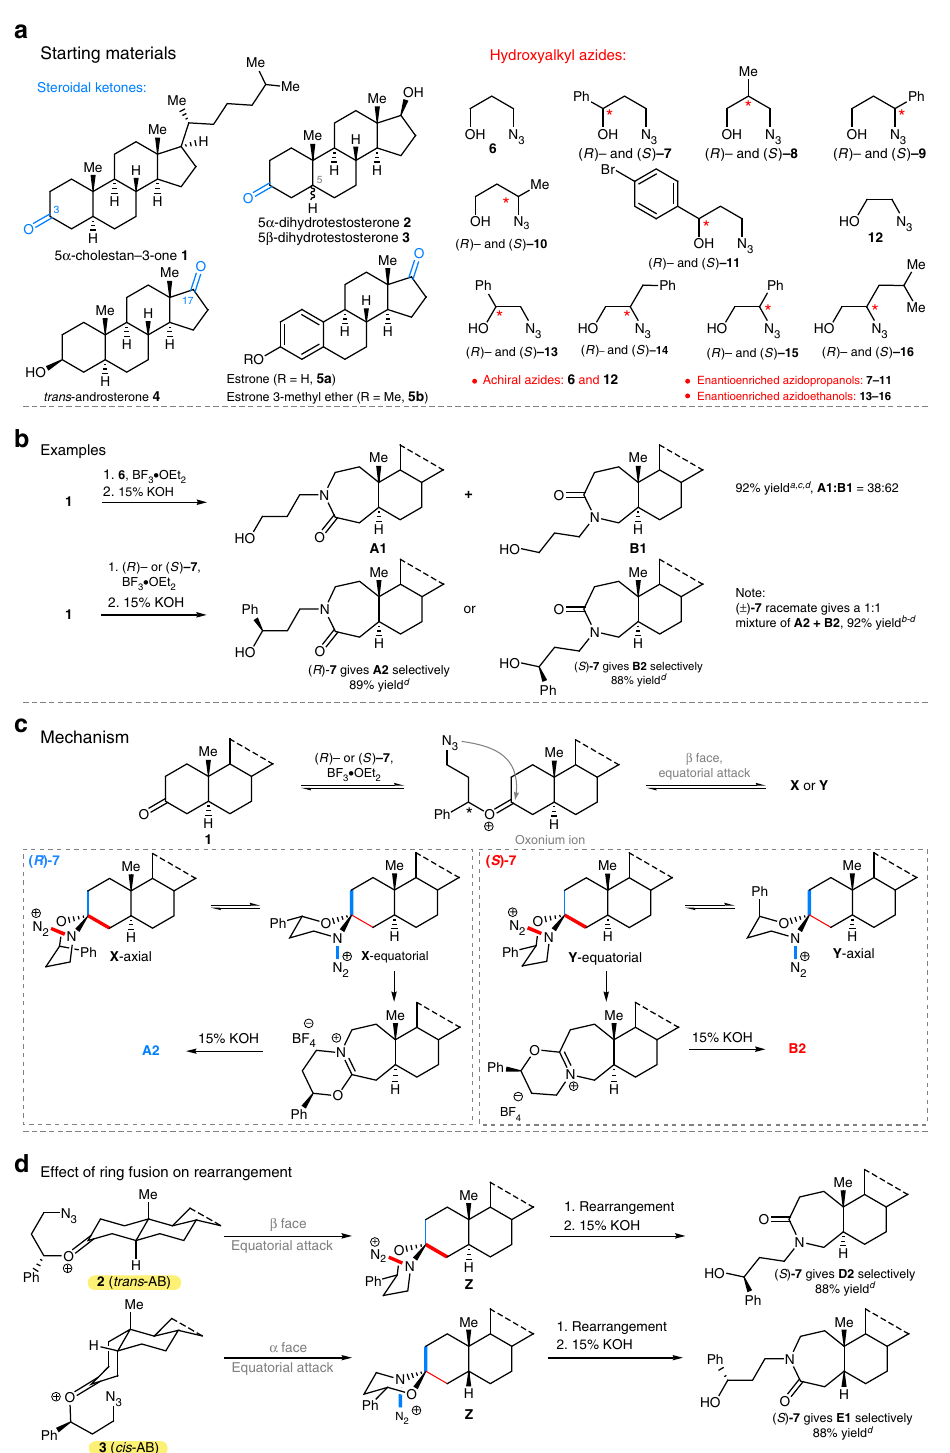
Fig. 2 Regioselective ring expansions of 3-oxosteroids. a Steroids and hydroxyalkyl azides used in this study. The blue ketones indicate modi fi cation sites. b Ring expansions obtained by treating 1 with 3-azidopropanol 6 , 3-azido-1-phenylpropanol ( R )- 7 and ( S )- 7 . c Mechanistic rationale for ring expansion chemistry differentiating between C-2 (blue bond) and C-4 (red bond) migration; key antiperiplanar relationship between the migrating group and the N 2 + leaving group is indicated by bold bonds. d Dependence of migration outcome on C-5 stereochemistry. a Inseparable mixture by normal phase chromatography. b Separable mixture by normal phase chromatography, but for this control experiment the isomers were not separated. c Ratio determined by 1 H nuclear magnetic resonance (NMR). d Isolated yield after chromatography on silica. See Supplementary Methods for full synthetic details. A and B series are 5 α -cholestan-3-one derivatives; D2 is a 5 α -dihydrotestosterone derivative; E1 is a 5 β -dihydrotestosterone derivative; X and Y are proposed spirocyclic intermediates (including both chair conformers as designated); 15% KOH, 15% aqueous solution of potassium hydroxide; *, signi fi es site of